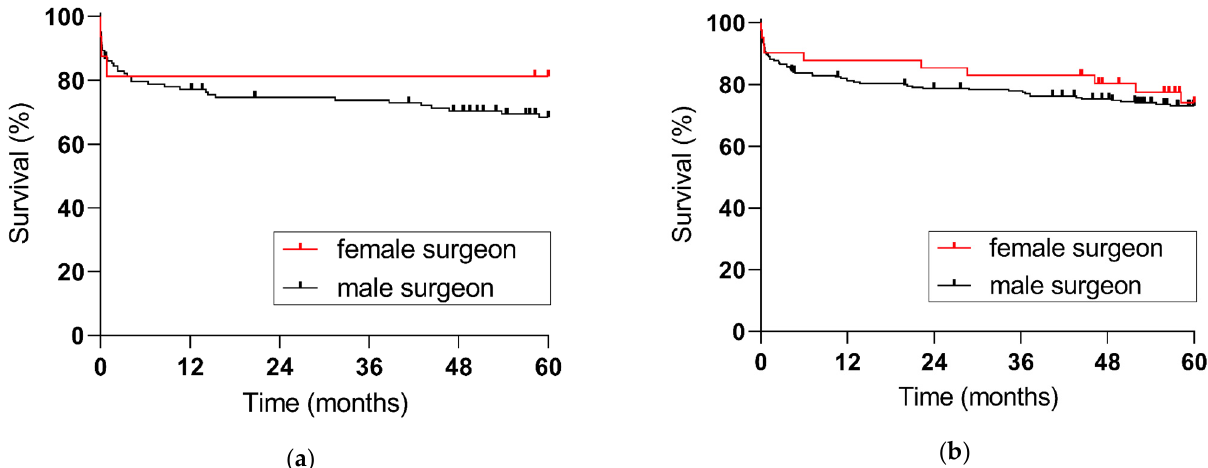
Figure 3. Five-year patient survival with regards to surgeon sex: a ) female recipients ( p = 0.3621), b ) male recipients ( p =